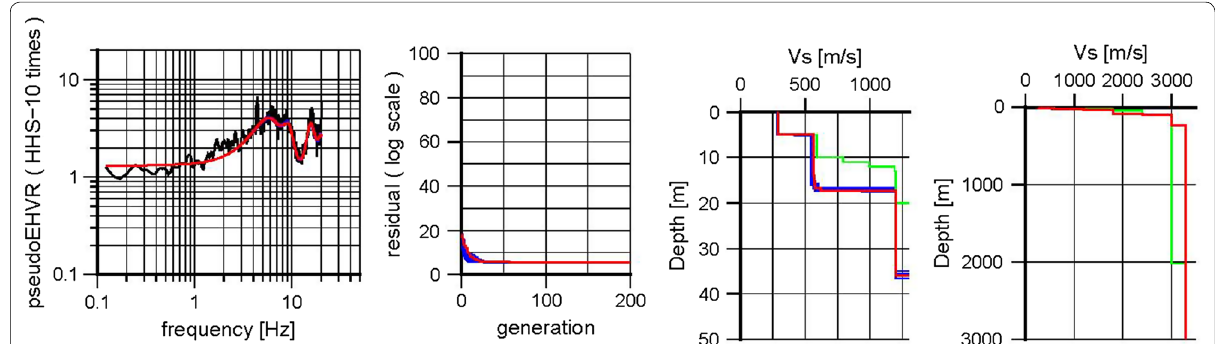
Fig. 15 Best-fit model (red line) in comparison with the translated pEHVR (black line) in the left panel, convergence with respect to the generation in the middle panel, and shallow (< 50 m) and deep (< 3 km) parts of the obtained S-wave velocities at EHM012 in the two right panels. Blue lines are those for ten trials with different genes, while red lines are values of the best model. Green lines in the two right panels are S-wave velocities of the initial model